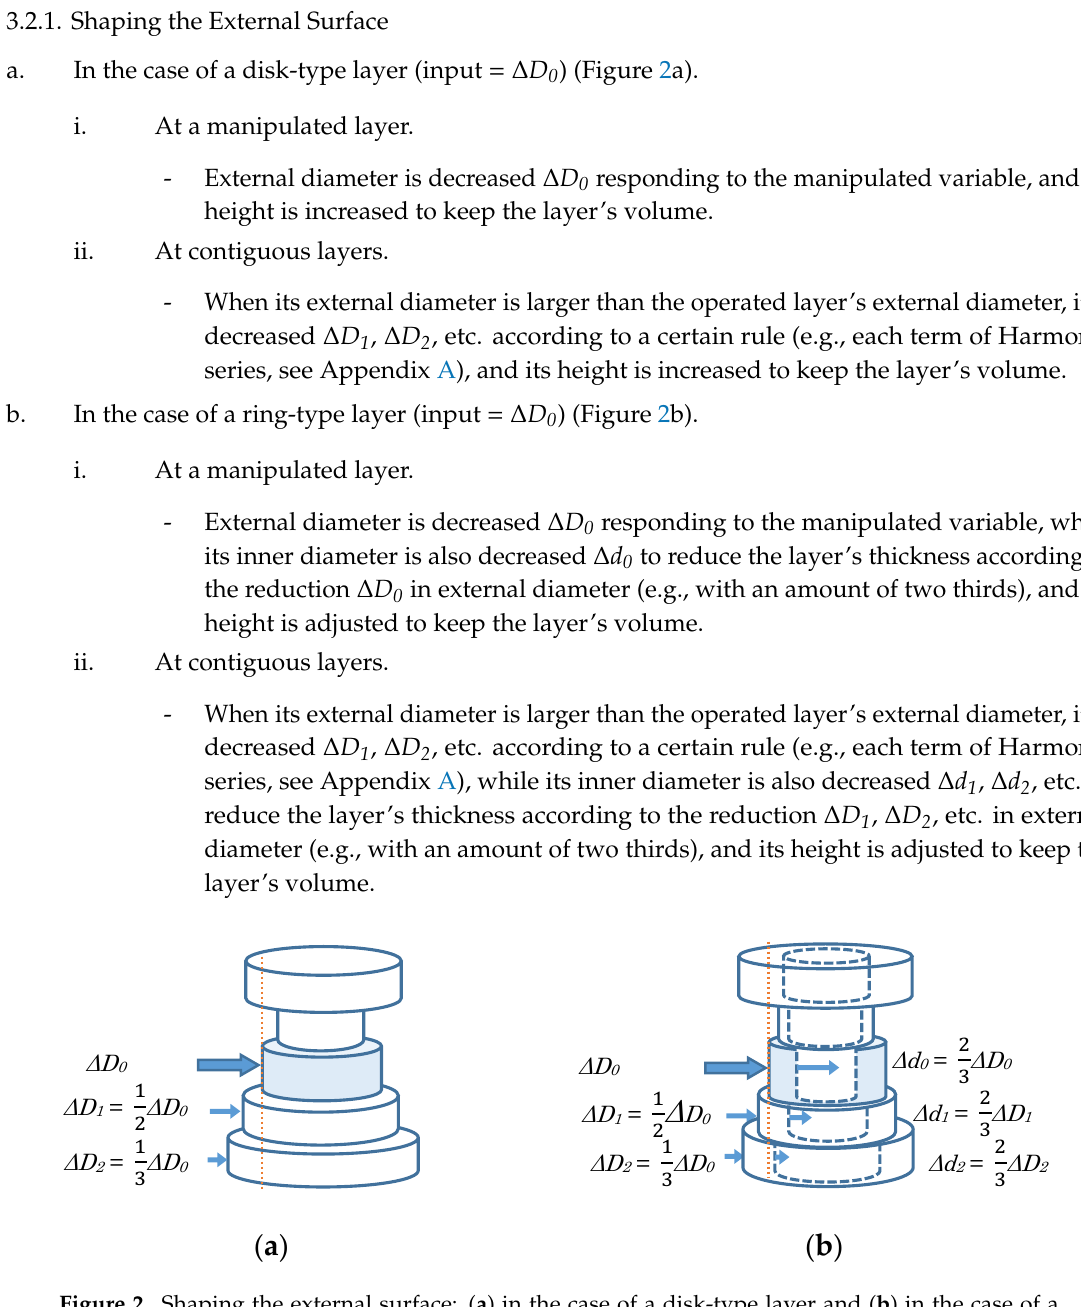
Figure 2. Shaping the external surface: ( a ) in the case of a disk-type layer and ( b ) in the case of a ring-type